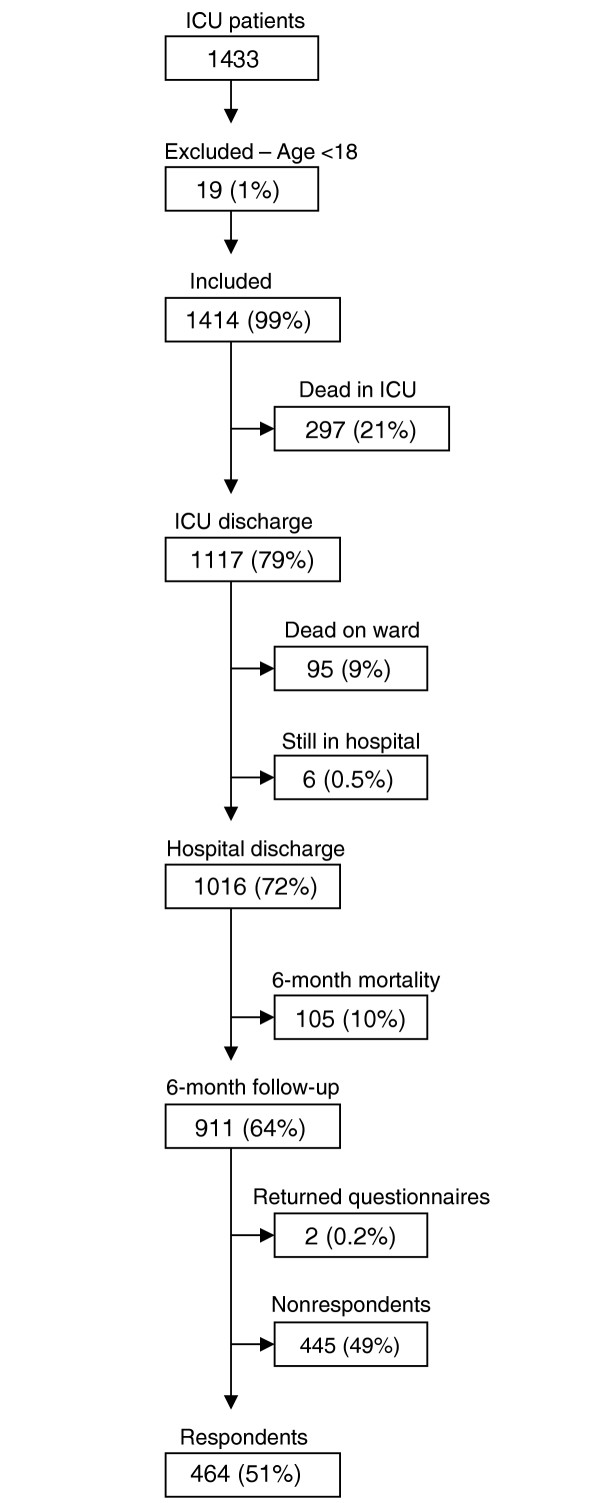
Patients included in and excluded from the study. Survival and recollection questionnaire response rates.